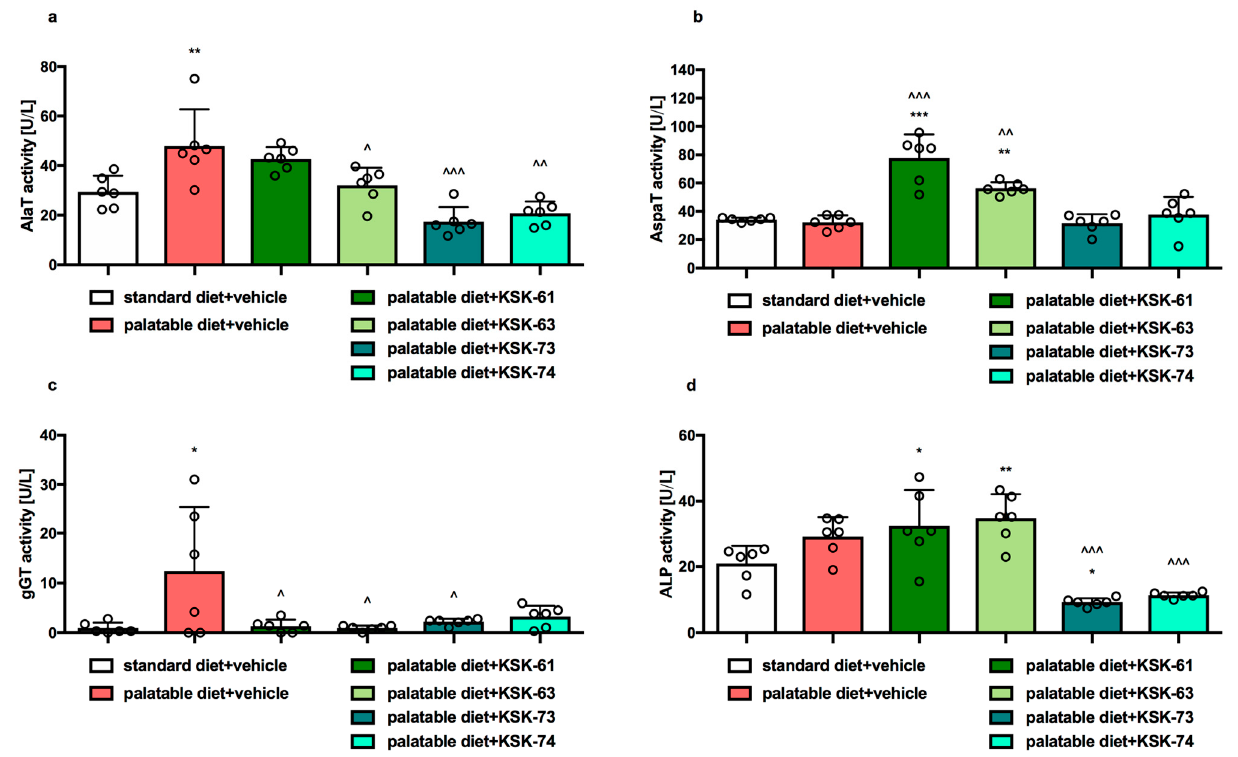
Figure 7. Effect of the tested compounds on plasma levels of ( a ) AlaT activity, ( b ) AspaT activity, ( c ) gGT activity, and ( d ) ALP activity. Results are presented as mean ± SD, n = 6. Comparisons were performed by one-way ANOVA and Tukey’s post hoc test. Significant against control rats fed a standard diet; *,^ p < 0.05; **,^^ p < 0.01; ***,^^^ p < 0.001.